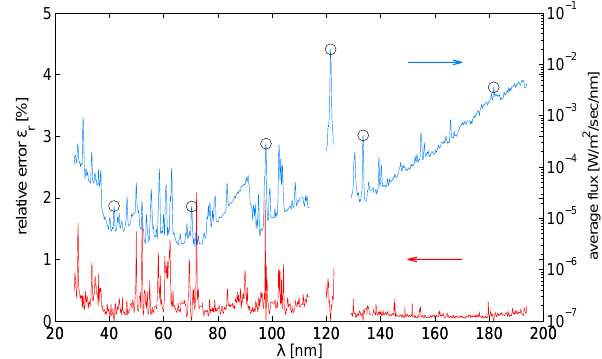
Fig. 10. The relative error ε r (λ) (in red) for the best combination of six lines (see Table 3). The average spectrum (in blue) is shown for comparison, with the six reference spectral lines